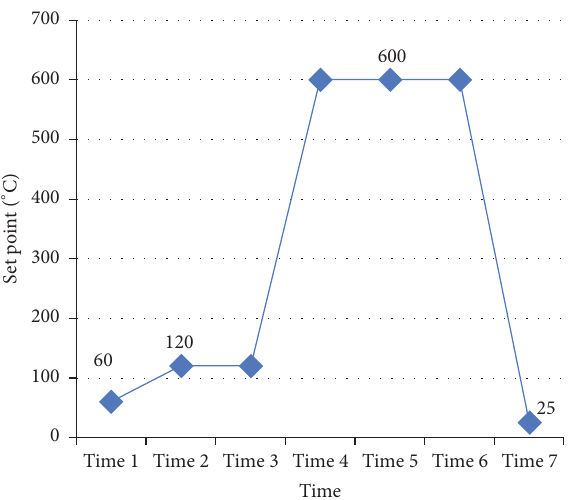
Figure 3: Schematic presentation of the controlled furnace temperature.